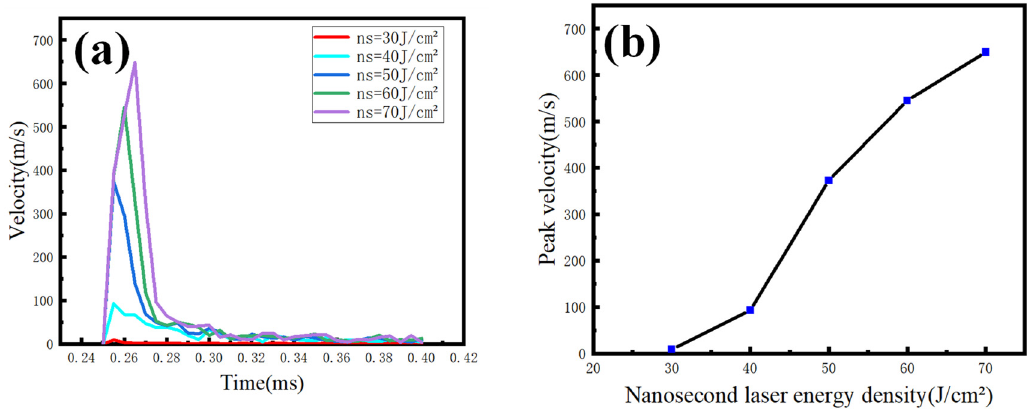
Figure 5. The variation in plasma expansion velocity under different nanosecond laser energy: ( a ) the relationship of plasma expansion velocity with time; ( b ) the relationship between plasma peak velocity and nanosecond energy density.